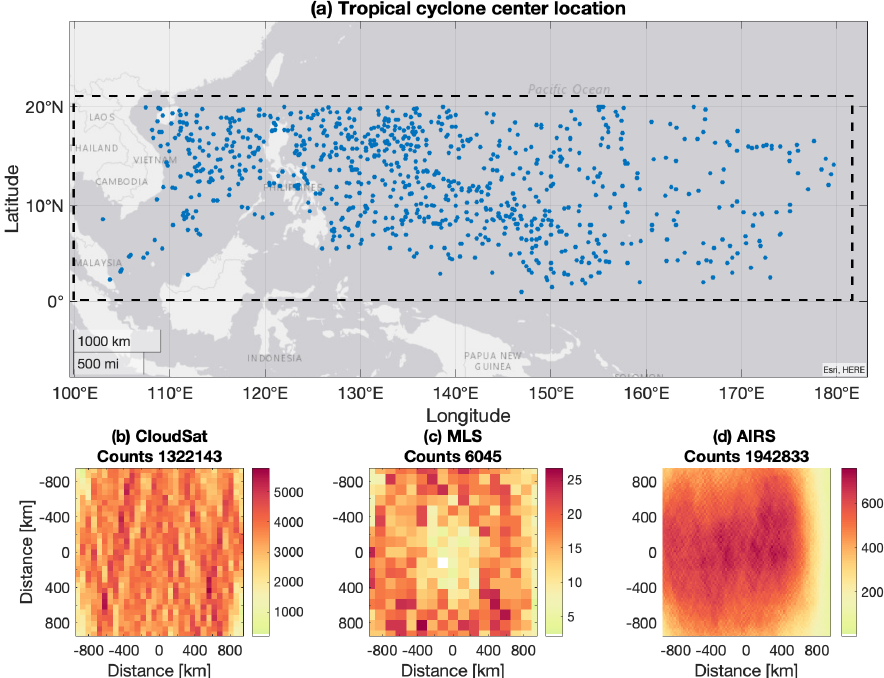
Figure 1. Distributions of cyclone centers passed over by A-Train and sample density from A-Train instruments with respect to cyclone center locations. (a) Locations of tropical cyclone centers (947 in total) that were passed over by the A-Train satellites from 2006 to 2016 over the northern part of the West Pacific region (within the boxed area). The sample density of (b) CloudSat (the DARDAR product is available at the horizontal footprints of CloudSat), (c) MLS, and (d) AIRS (limited to viewing angles within 15 ◦ of the nadir) with respect to distances to cyclone center locations. The sample densities are defined as the number of samples per 100km × 100km area, measured by normalizing sample counts within every 60km (b) , 120km (c) , and 20km (d) grid box over the area of the grid box. The numbers at the top of each panel show the total number of samples.